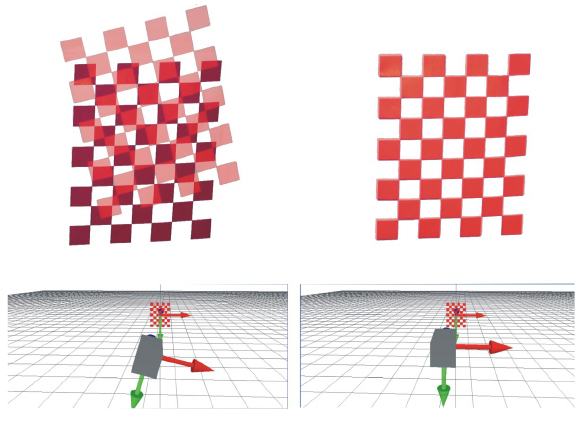
Figure 9. Fitting process example. Top : projected view by the virtual camera; bottom : virtual